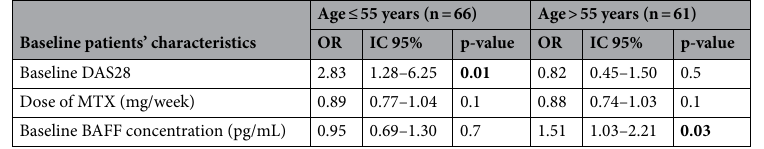
Table 3. Association between baseline BAFF concentration and the development of ADA at 6 m, stratified by age. Logistic regression analysis adjusted by baseline DAS28 and the dose of concomitant MTX. Odds ratio (OR) and 95% confidence interval (CI) and p-values were calculated. Significant statistical differences are noted in bold. p-value < 0.05 was considered as statistically significant. DAS28 disease activity score-28, MTX methotrexate, BAFF B cell activating factor.